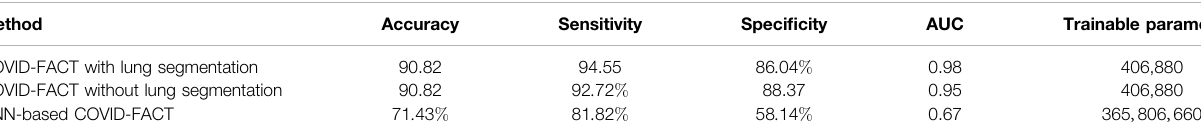
TABLE 2 | Results obtained from COVID-FACT and the alternative CNN-based model.